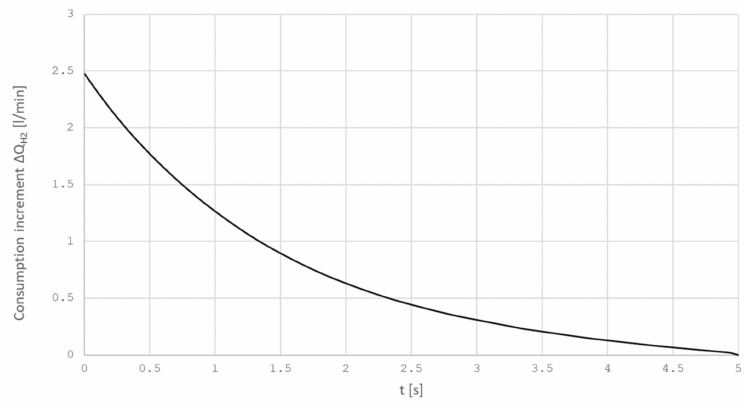
Figure 16. The consumption increment ∆ Q H2 from the control time τ